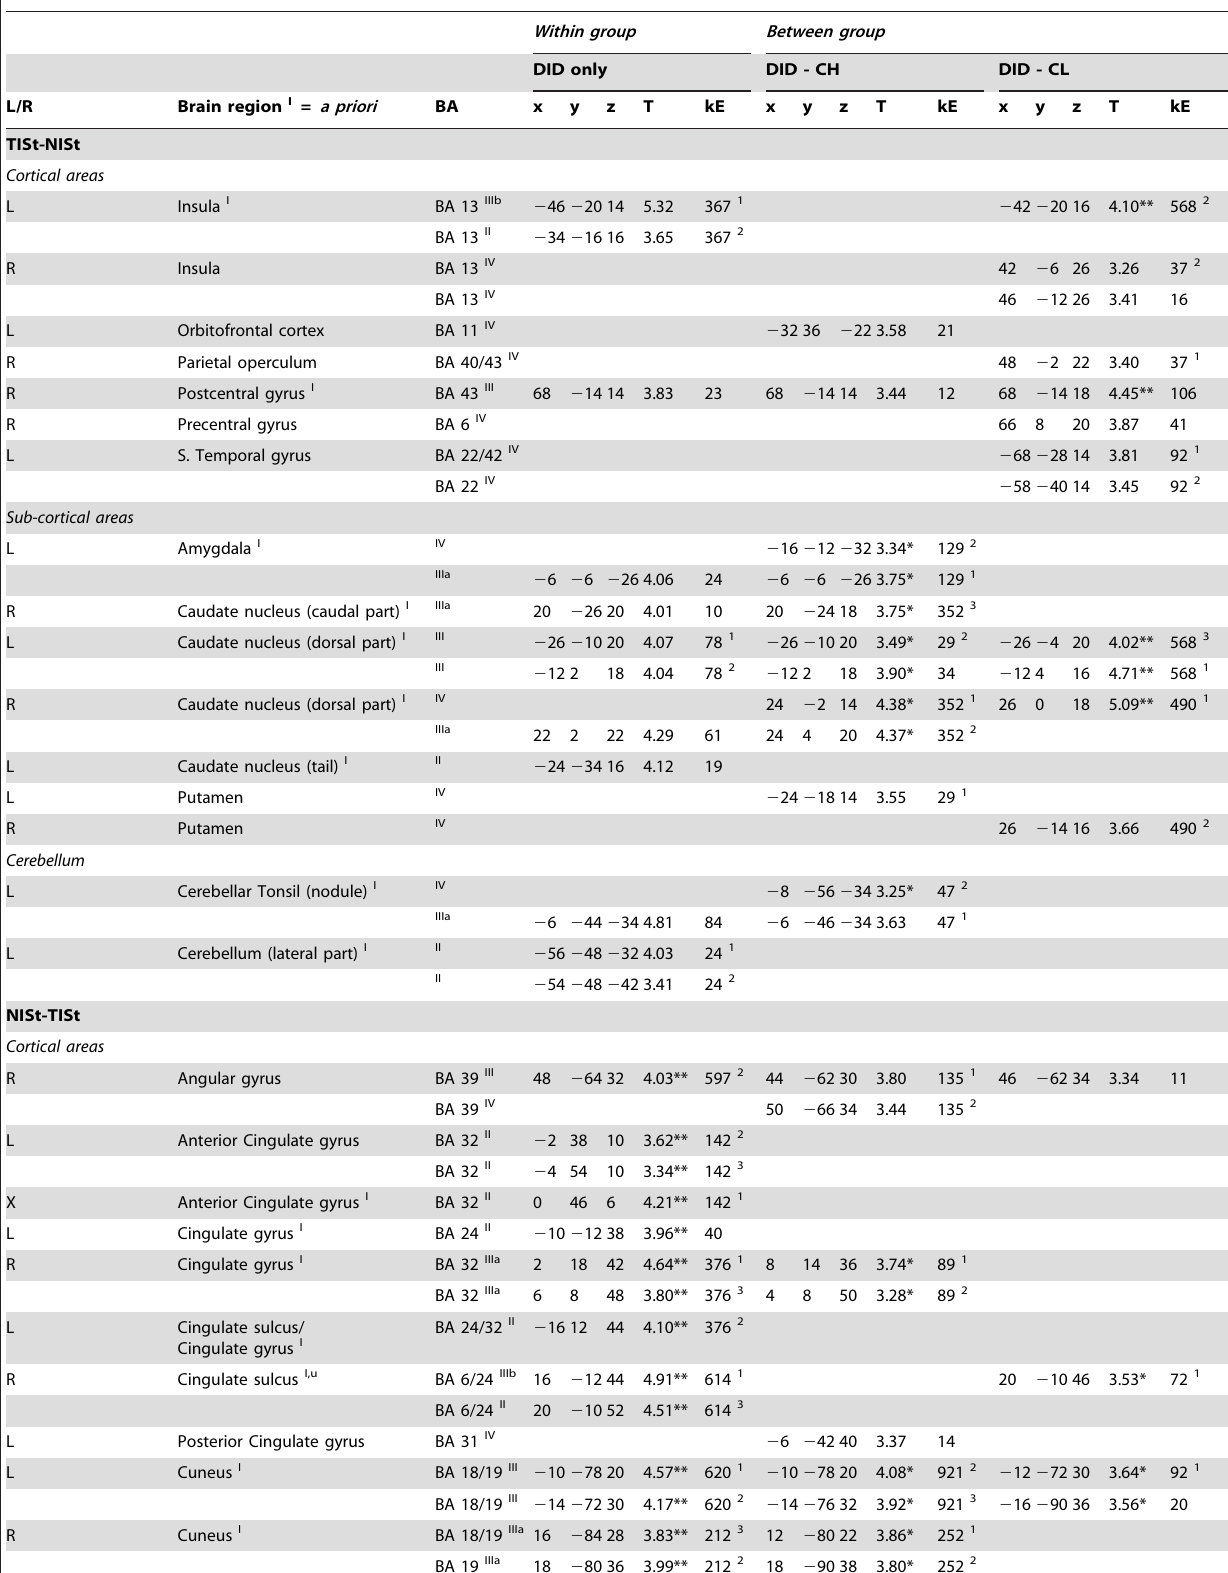
Table 4. Memory script effects between dissociative identity states.